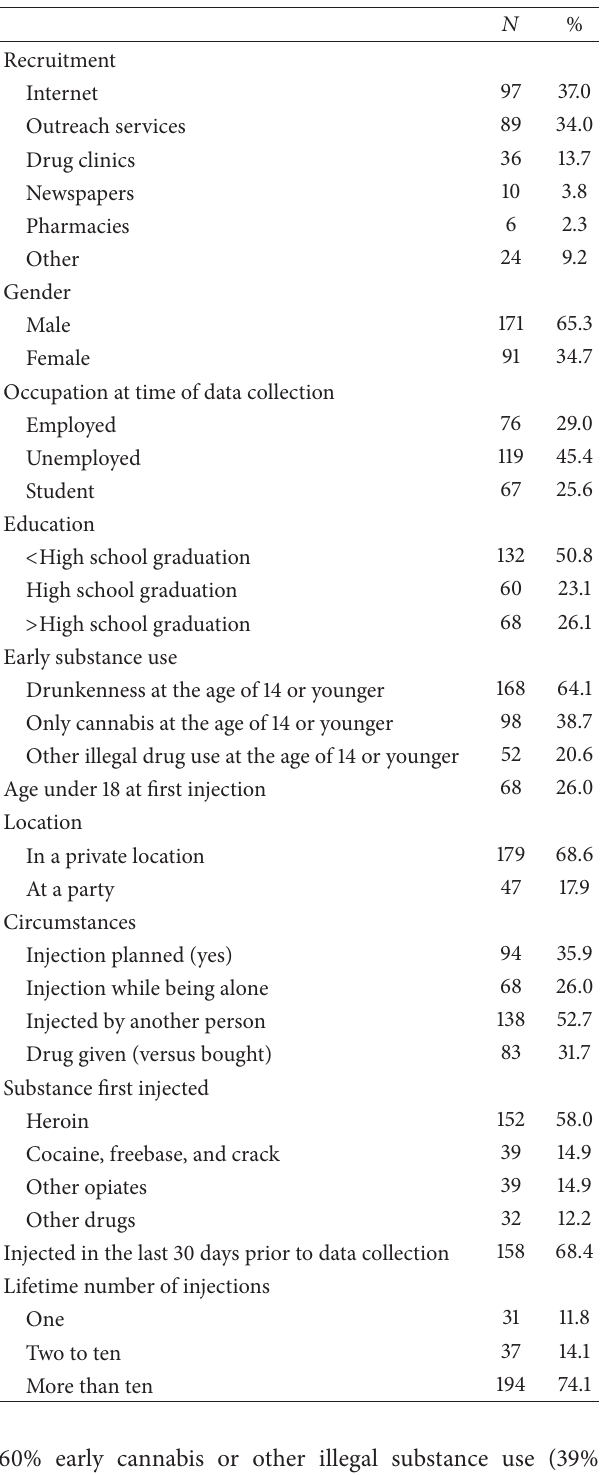
Table 1: Characteristics of the sample ( 𝑁 = 262 ): numbers and